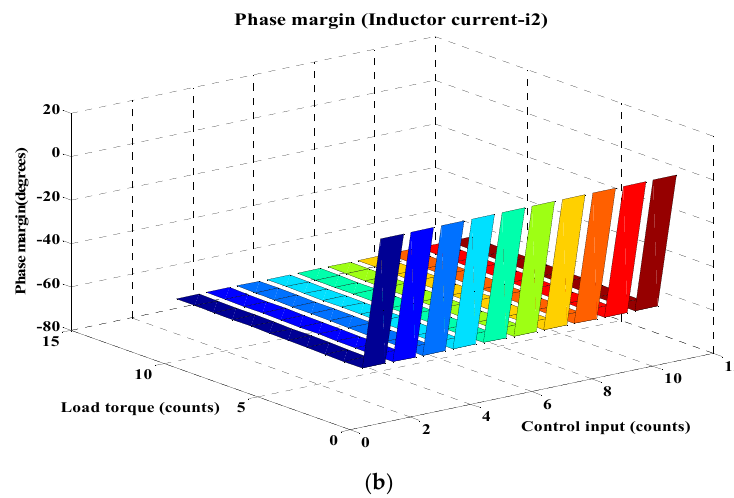
Figure 13. Frequency response of inductor current (i 2 ). ( a ) Gain margin; ( b ) Phase margin.